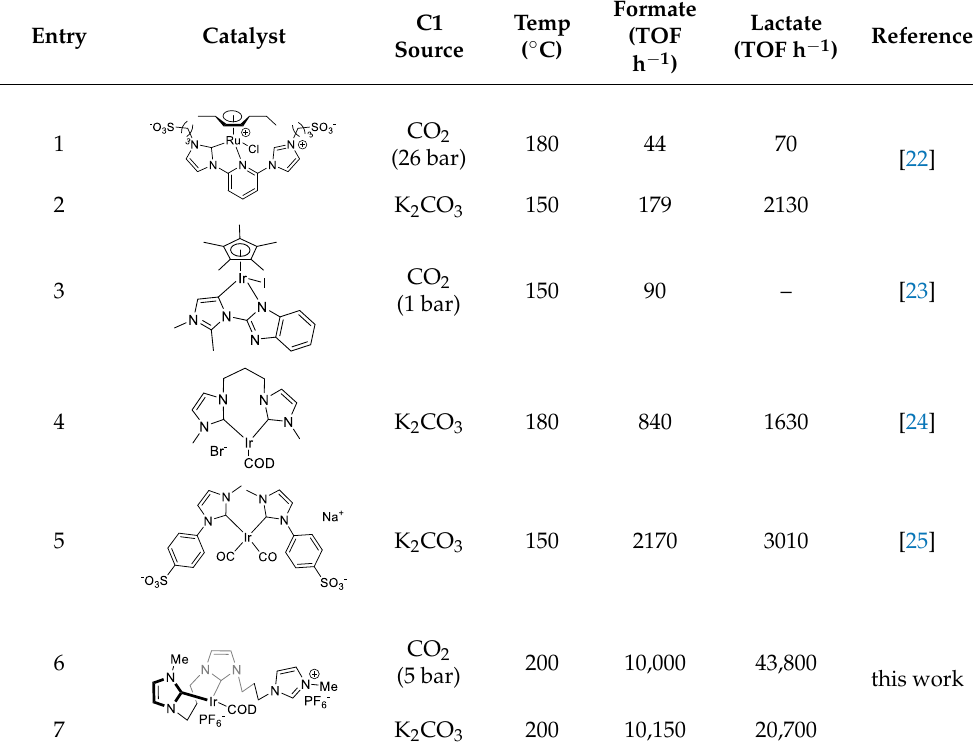
Table 3. Previously reported catalysts for the transfer hydrogenation of CO 2 and inorganic carbonates with glycerol.